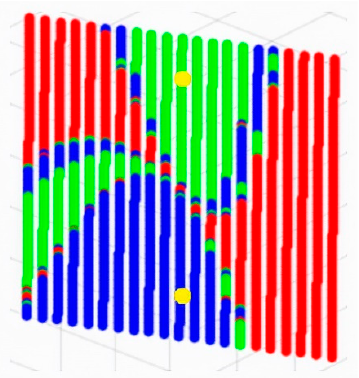
Figure 1. Plane of convergence containing the two solutions of a four-beacon TDOA problem.